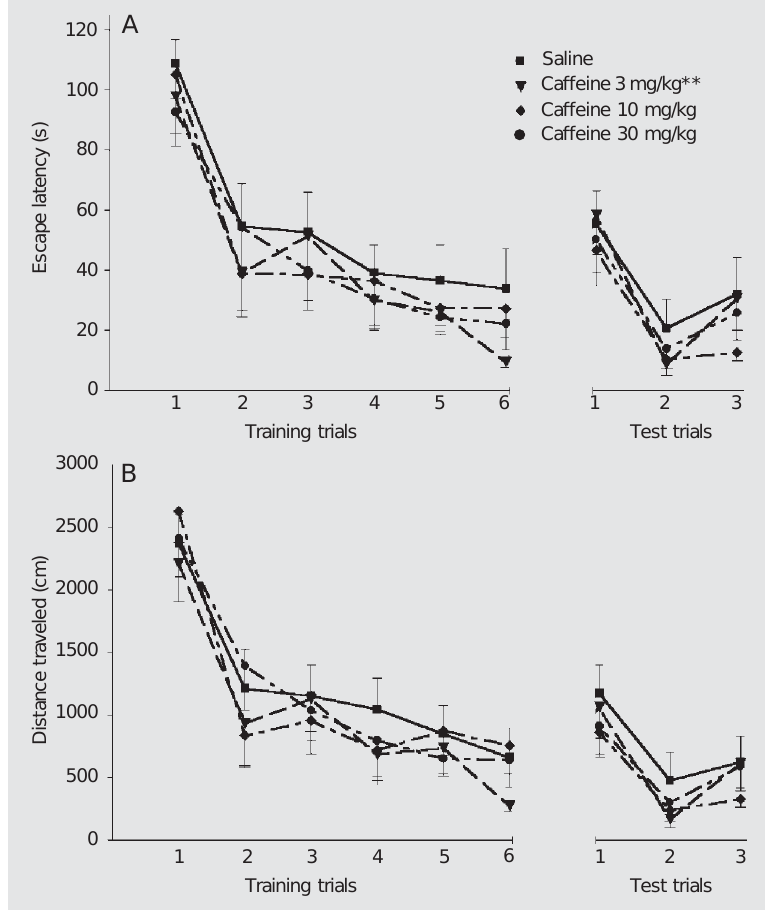
Figure 1. Effect of the administration of caffeine 30 min before the training session on the learning of the Morris water maze task. The results are reported as mean ± SEM latency (A) or distance (B) the animals traveled from the starting point to the submersed platform. The test trials were performed 48 h after the training trials. The X-axis represents the starting position for each trial. Two-way ANOVA showed a significant decrease in the scores as a function of the number of trials (P (cid:1) 0.05) but no significant effect of treatment either on the training or on the retention (test session) scores. Figure 2. Effect of the administra- tion of caffeine 30 min before the training session on swimming speed during the Morris water maze training trials. The results are reported as mean ±